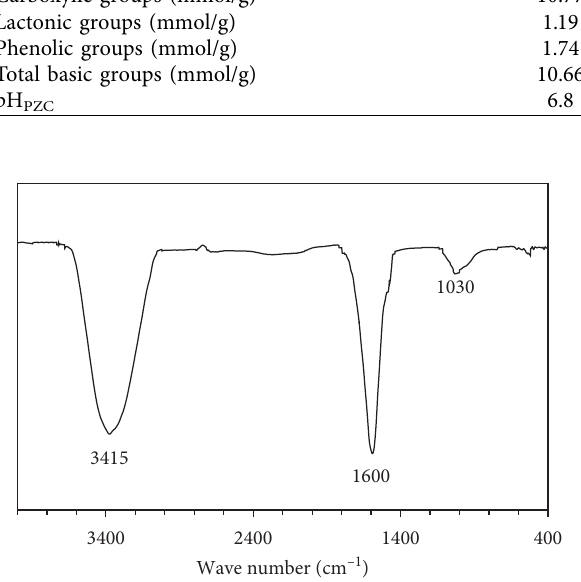
Figure 1: FT-IR spectra of AC carbonized at 500 ° C, activated at 500 ° C/2h/2 (gH 3 PO 4 /g carbon).